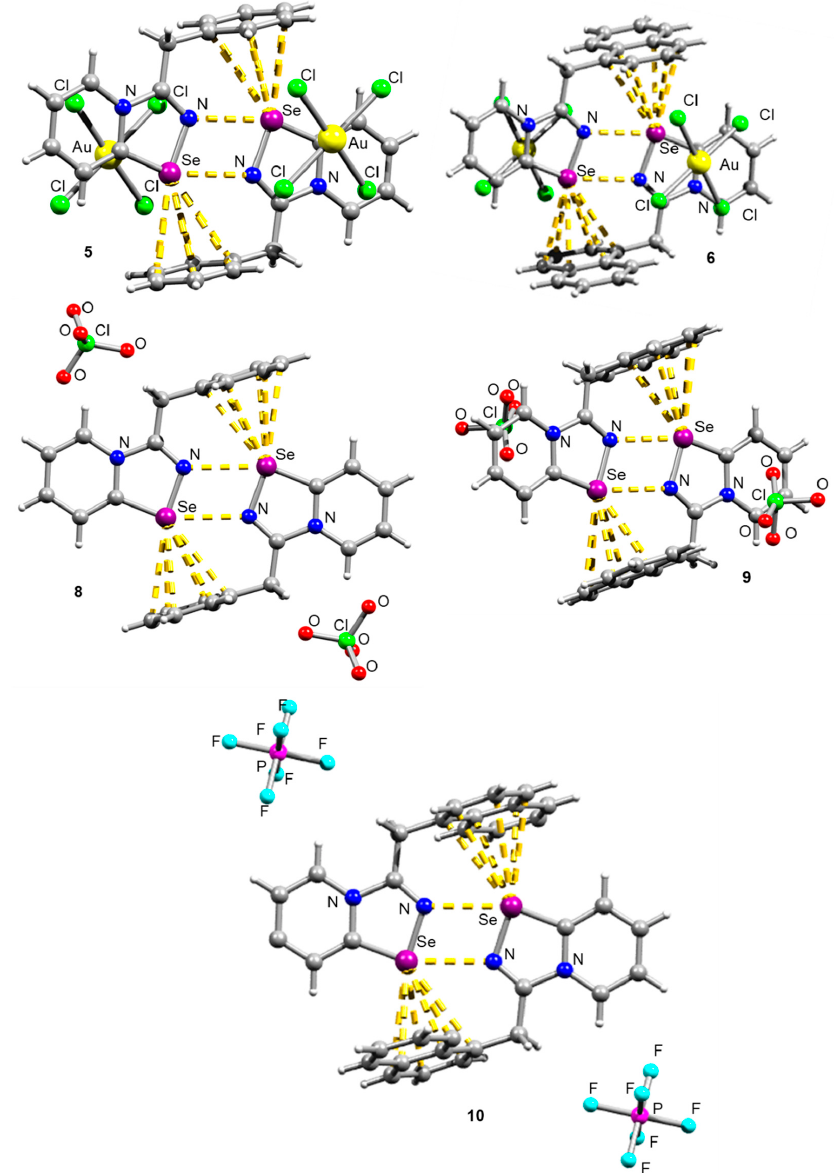
Figure 2. Ball-and-stick representations of crystal structures of 5 , 6 , 8 , 9 , and 10 , demonstrating supramolecular dimerization via two Se ⋯ N and Se ⋯ π ChB interactions. Grey and light-grey spheres represent carbon and hydrogen,